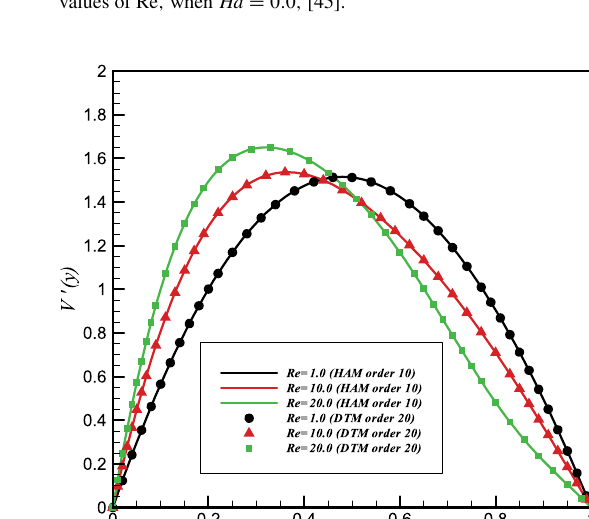
Fig. 9. The profile V ( y ) obtained by the 10th-order approximation of the HAM and 20th-order approximation of the DTM for different values of Re , when Ha = 0 . 0 , [45].